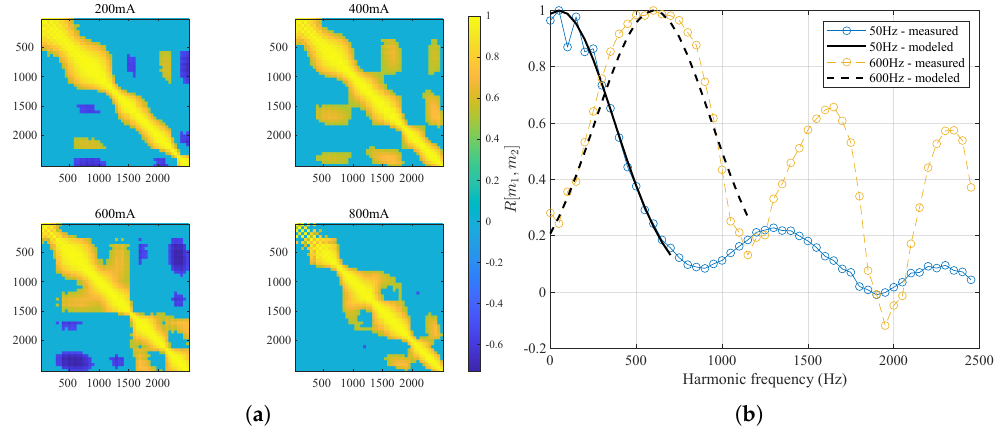
Figure 9. Correlation of harmonics coefficients. ( a ) Covariance matrix visualization. ( b ) Selected harmonics with Gaussian radial function